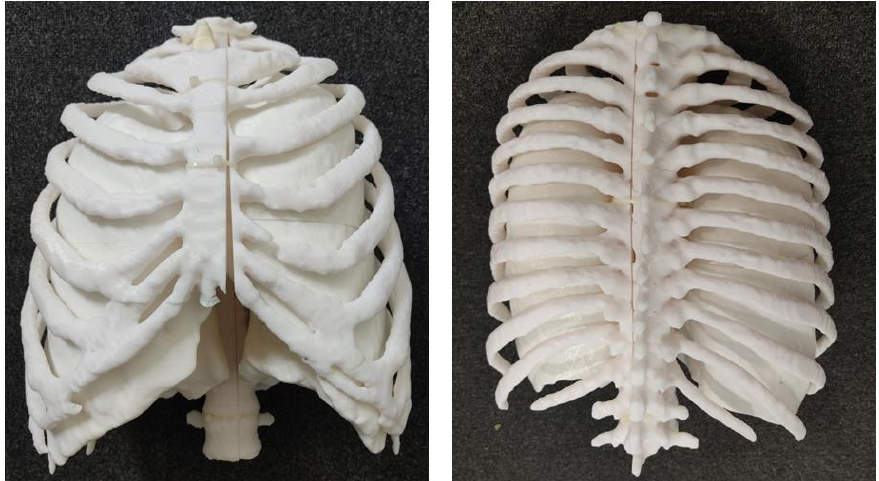
Figure 22. 3D-printed chest model comprising three components: lung shells, thoracic ribs, thoracic vertebrae and trachea (frontal and posterior views).